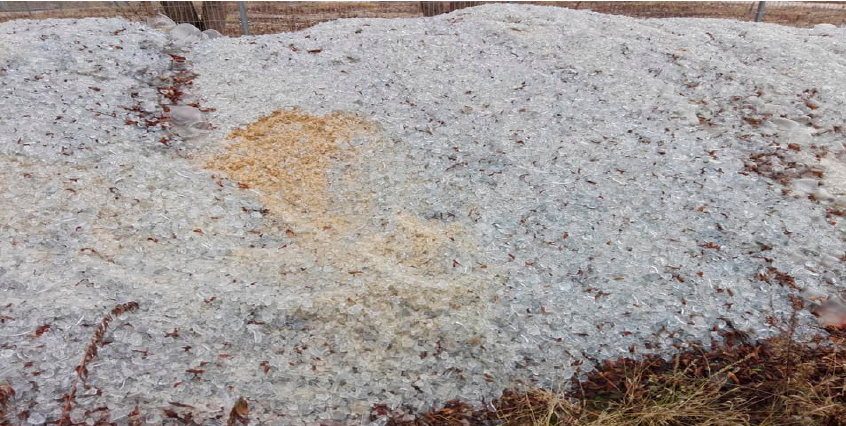
Figure 1. Heap with heat-resistant glass cullet formed on the premises of the Termisil S.A.